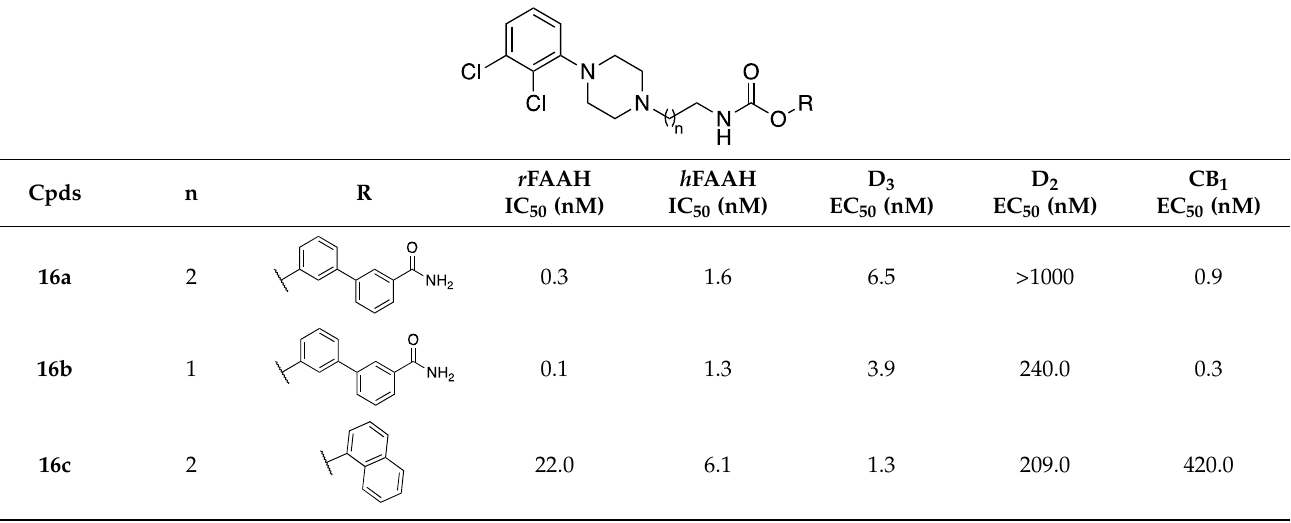
Table 10. Inhibitory activities against rat and human FAAH, D 3, and D 2 dopamine receptors, and CB 1 receptors.